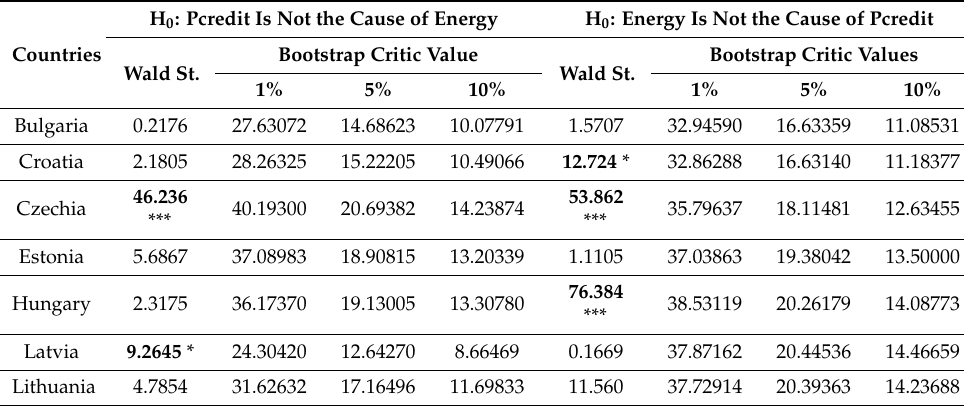
Table 9. Causality analysis between private credits and primary energy